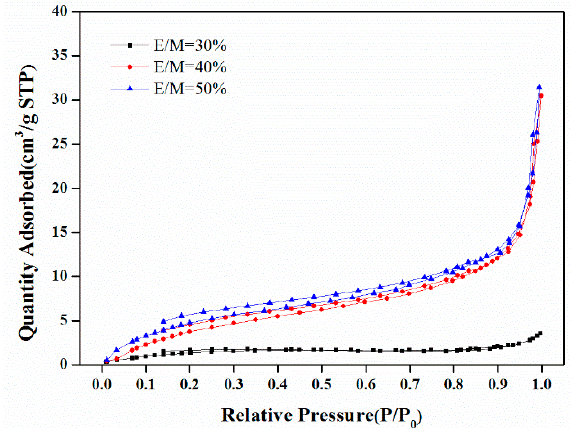
Figure 7. N 2 adsorption-desorption curves of the polyHIPE scaffolds fabricated with different emulsifier amount.